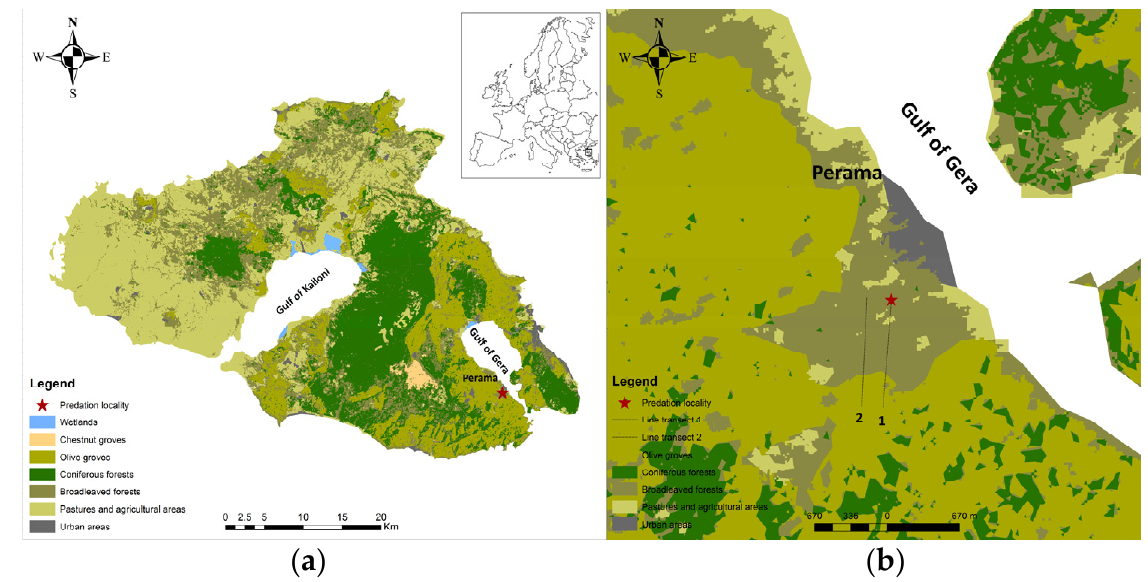
Figure 1. Distribution map of the main land cover types of the island of Lesvos along with ( a ) the locality of the incidental predation event and ( b ) the line transects.